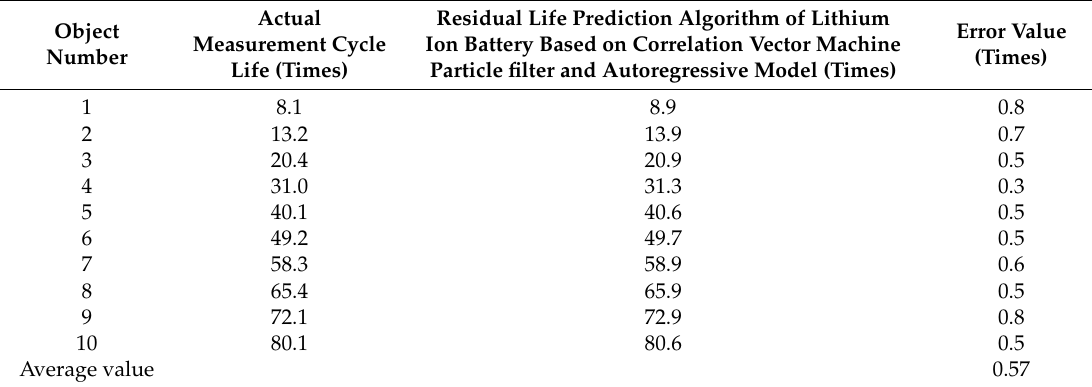
Table 9. A detection system for the residual life prediction of lithium-ion batteries based on the correlation vector machine, particle filter and autoregressive model.